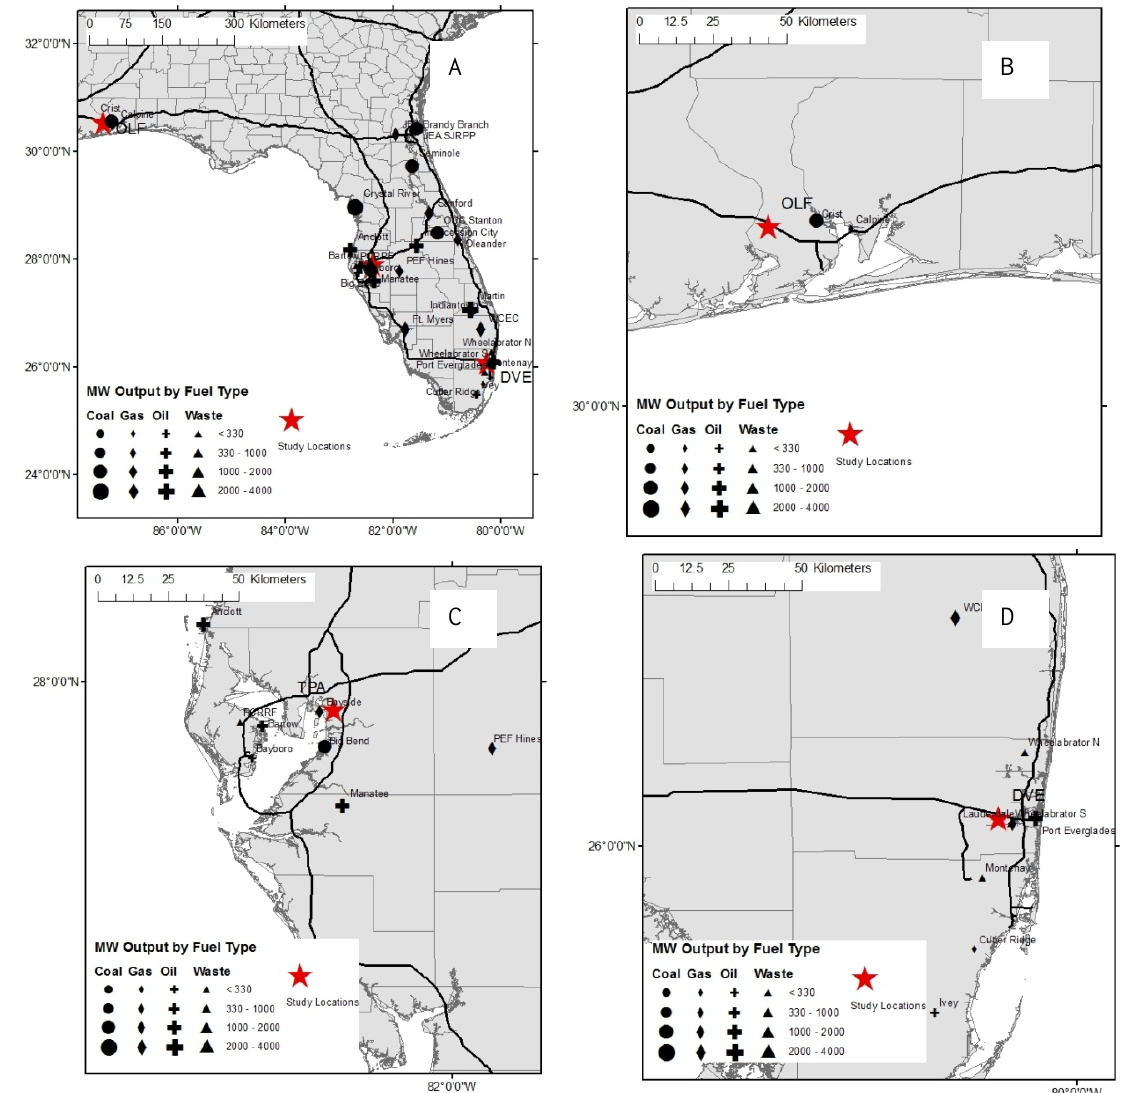
Figure 1: A) Map of Florida, located in the southeastern United States, showing the study locations and Florida electrical generation units (EGPs) with > 1000 MW output segregated by primary fuel type. Also shown are more detailed maps of area surrounding study sites and all EGUs within a 50 km radius for B) Pensacola, C) Tampa and D) Ft. Lauderdale areas.